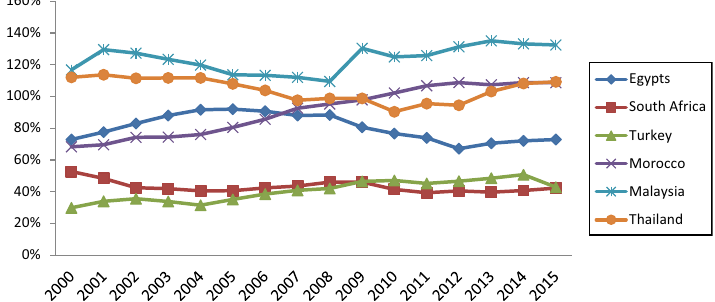
Figure 6. Ratio of liquid